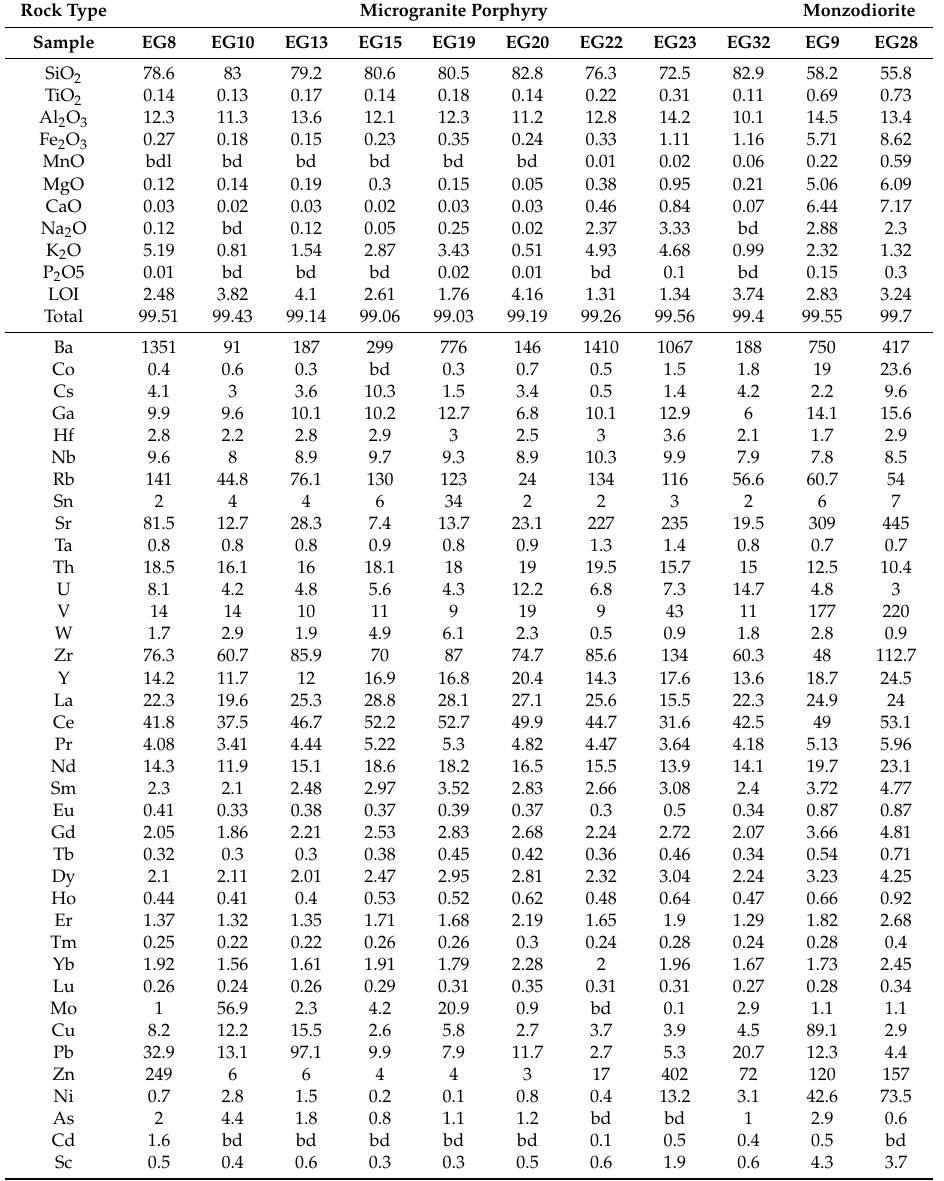
Table 1. Chemical composition of rock samples from the Aisymi-Leptokarya prospect. Values are in wt.% for major elements (acquired by XRF) and in ppm for trace elements (acquired by ICP-MS). Rock